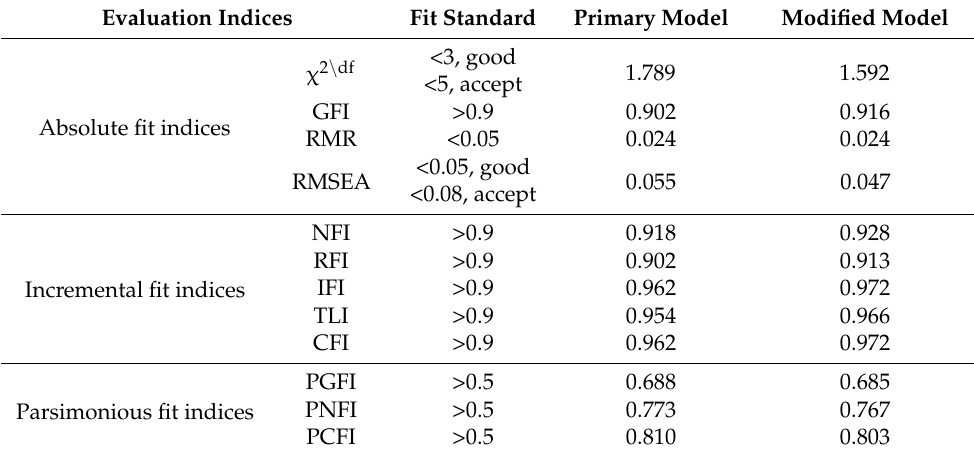
Table 5. Model adaptation